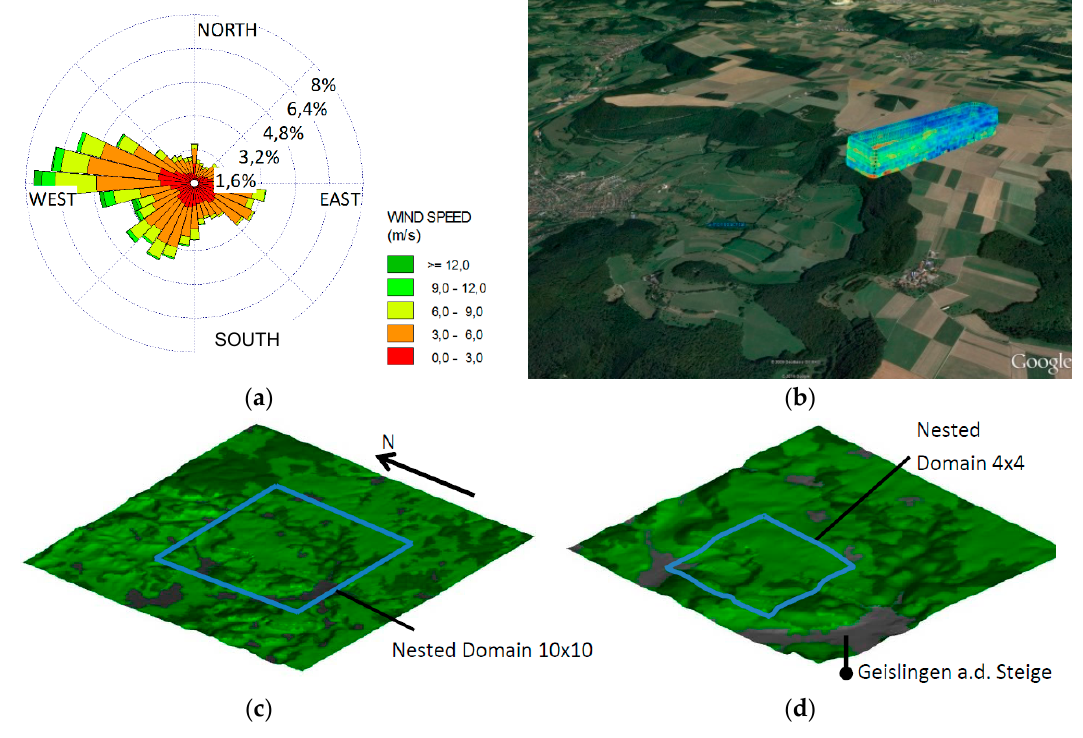
Figure 4. ( a ) Wind rose in the timeframe 2014–2015 at DWD measuring station Stötten (734 m a.s.l., 48.6654° latitude, 9.8655° longitude); ( b ) unmanned aerial vehicle (UAV) measurement race tracks (© 2009 GeoBasis-DE/BKG, © 2016 Google); ( c ) parent model; ( d ) nested domain 10 × 10.